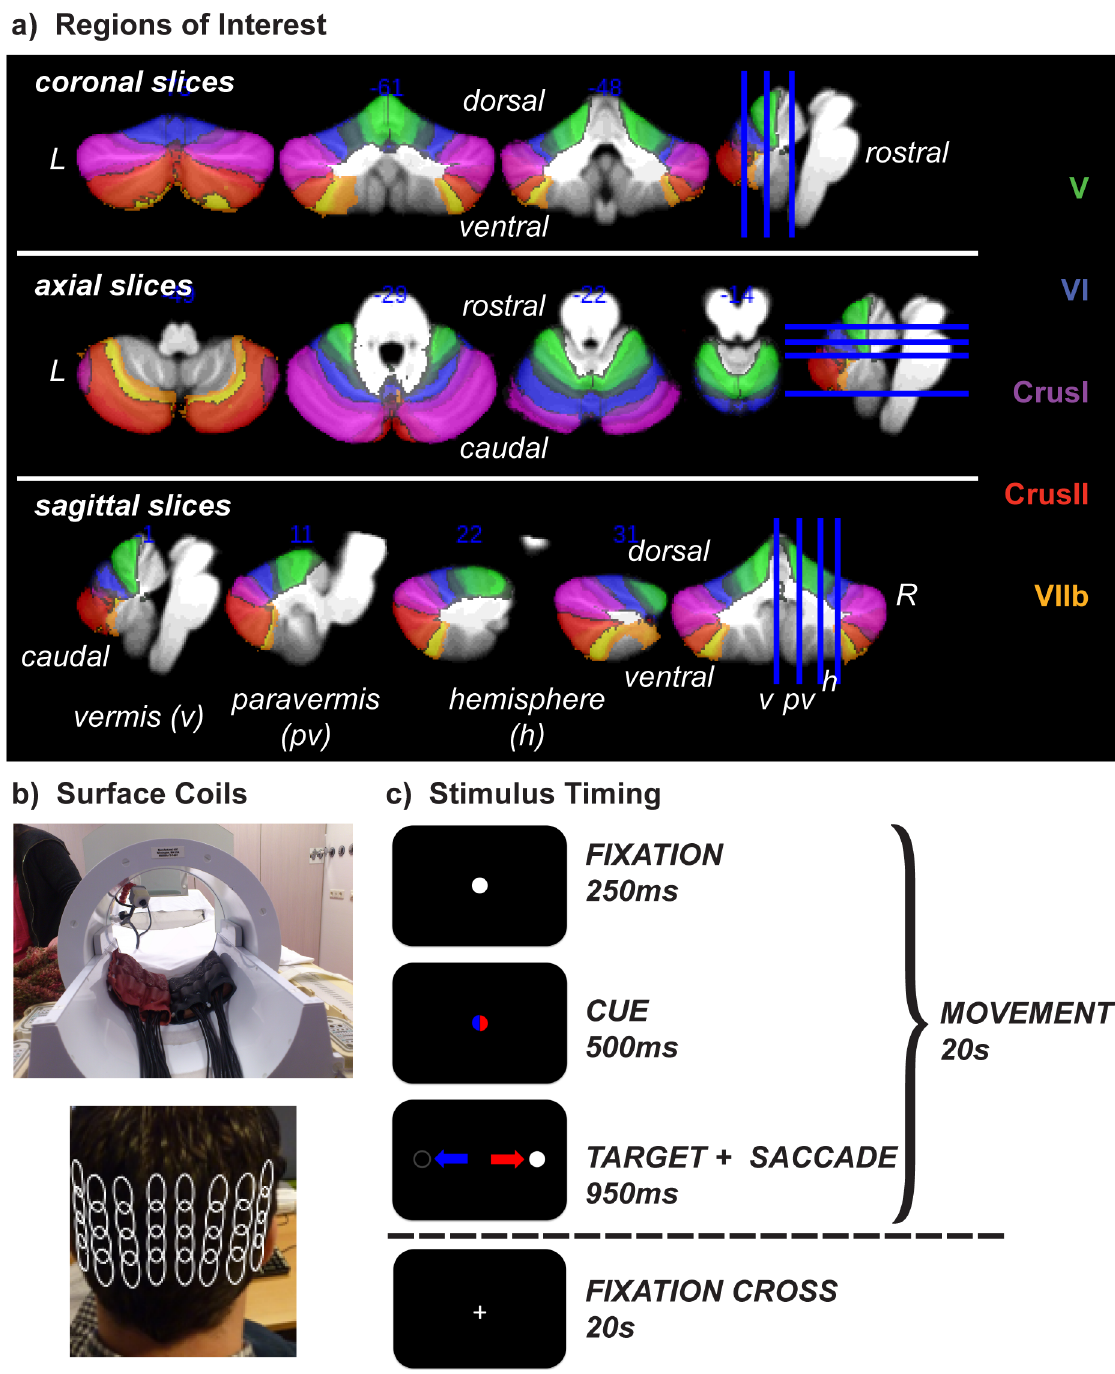
Fig 1. Experimental Design. a) Cb is divided into three main parts — vermis (medial Cb; will be denoted in the text with a “ v ” ), paravermal (medio-lateral Cb) and hemispheres (lateral Cb; both of which will be denoted collectively in the text with an “ h ” ) – which are then further divided into ten numbered lobules, arranged dorsoventrally I-X. Task-related activations were expected in five regions of interest: oculomotor vermis ( v VI-VII) & h VIIb for the PA task, with possible cognition-related activation in lobules CrusI & CrusII ( h VII), and in h V & h VIII for the FT task. These lobules are color-coded and overlaid on an average Cb from the SUIT toolbox [20] and listed, in matching colors, on the right. b) top – Two high-density surface coils with 16 elements each were used for signal reception (adapted from [21]), bottom – the coils were placed beneath Cb using the inion of the skull as a landmark and accurate placement was confirmed with a scout scan. c) The stimulus sequence was identical for both eye- and finger-movement tasks: In the pro-/anti-saccade (PA) task subjects made eye movements to locations which were either identical to (pro-saccade) or opposite from (anti-saccade) the location of a white target that appeared